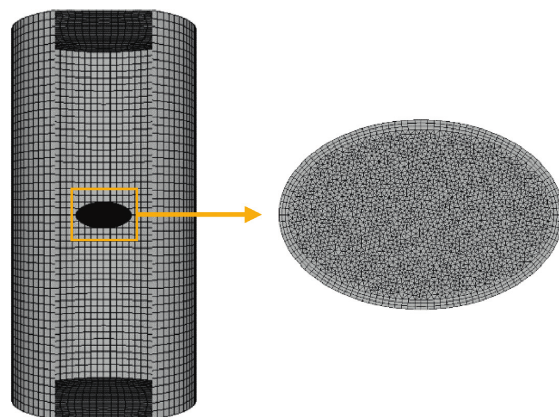
Figure 10: Mesh generation of the numerical model.